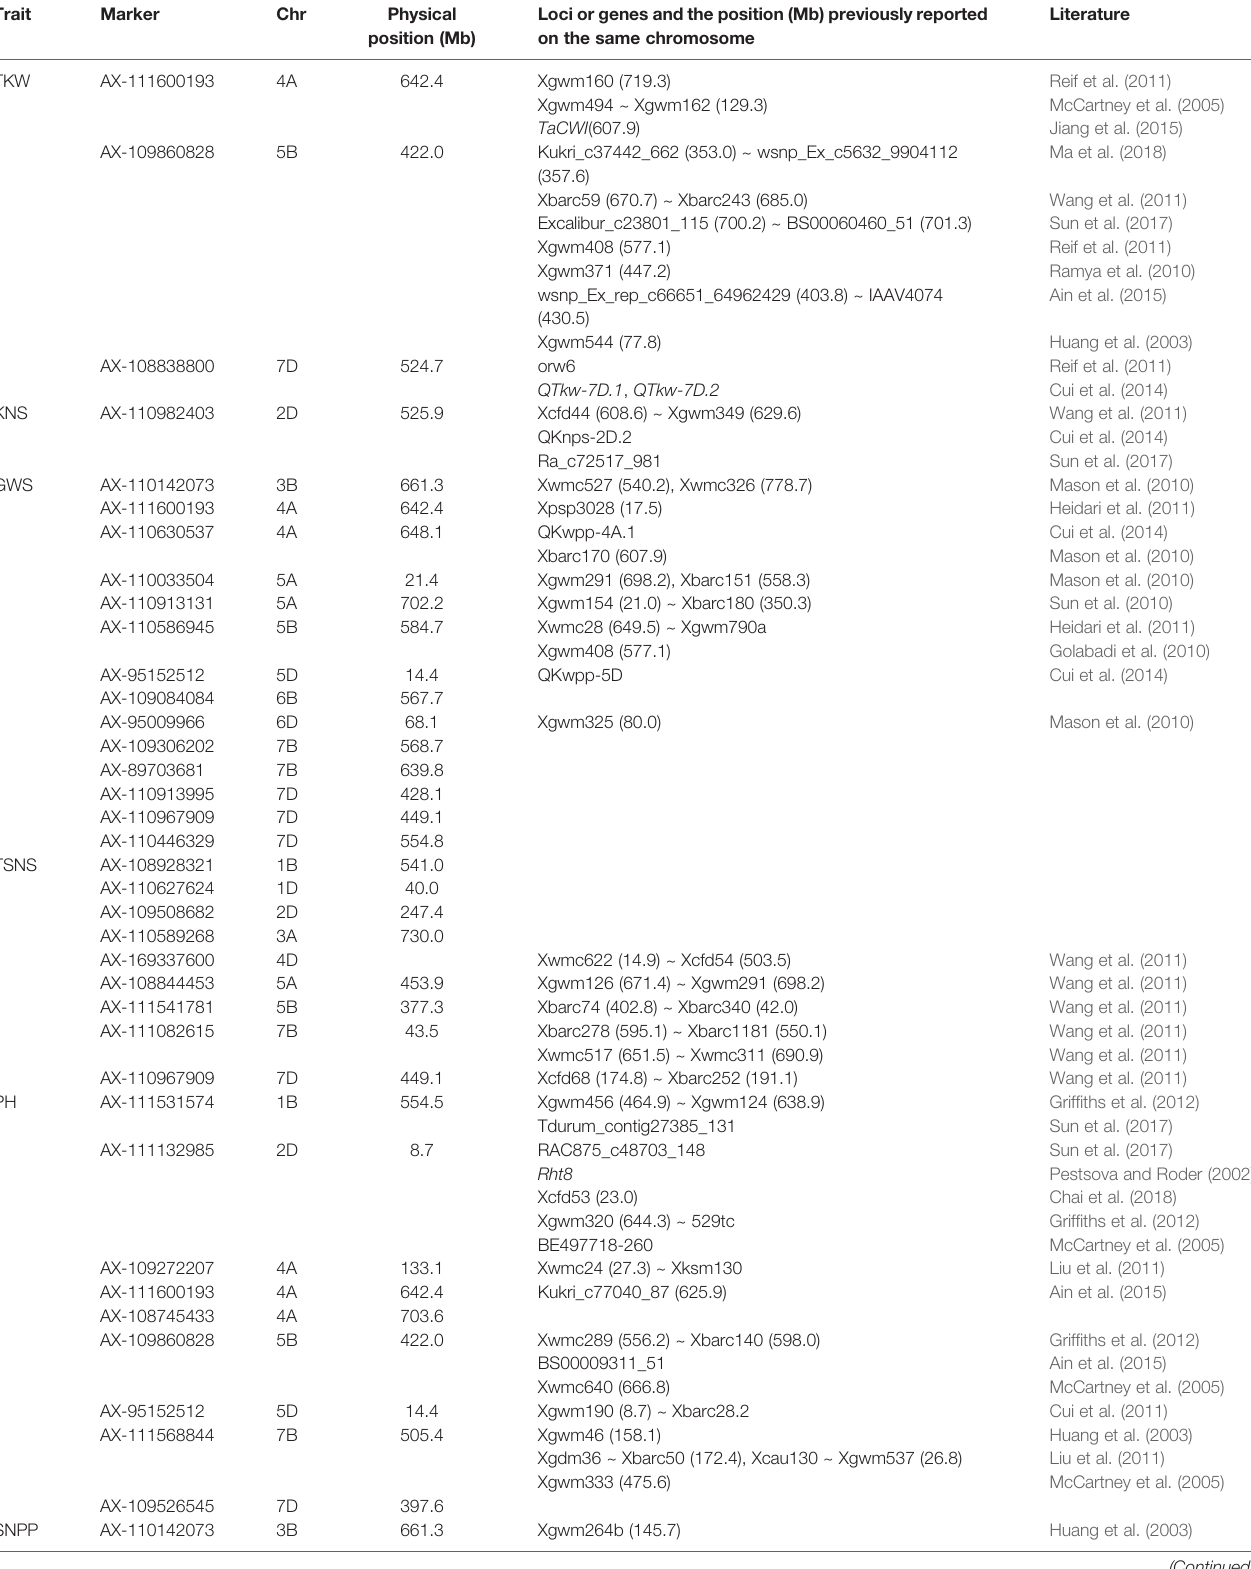
TABLE 1 | Comparison of important SNP loci between this study and previous studies. Trait Marker Loci or genes and the position (Mb) previously reported on the same